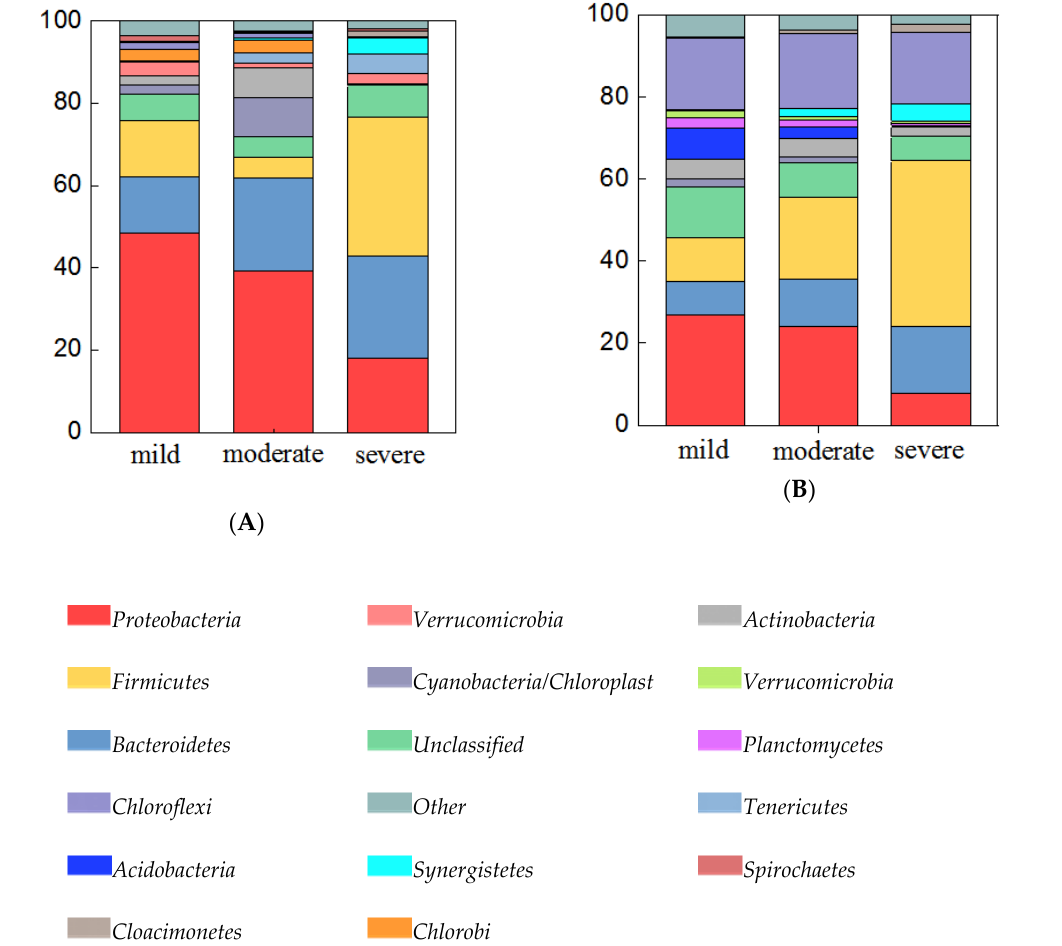
Figure 4. Bacteria abundance (abundance > 5%) at the phylum level in water samples ( A ), and sediment samples ( B ). Categories with abundance < 1% are summarized as “others”.